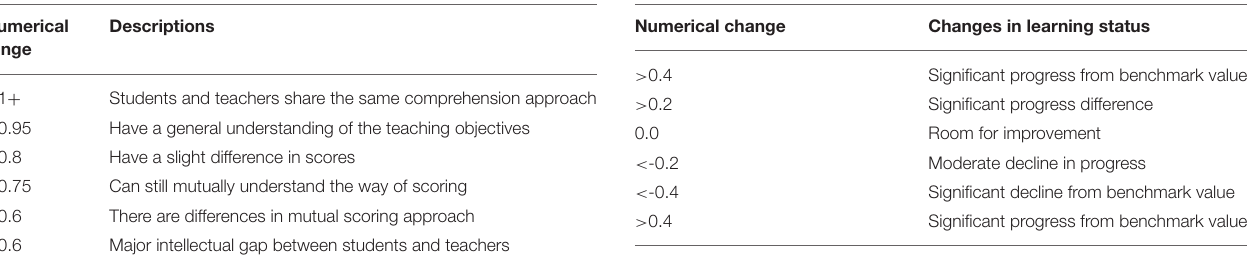
TABLE 3 | Student professional approach table. TABLE 4 | Student self-professional growth change table.